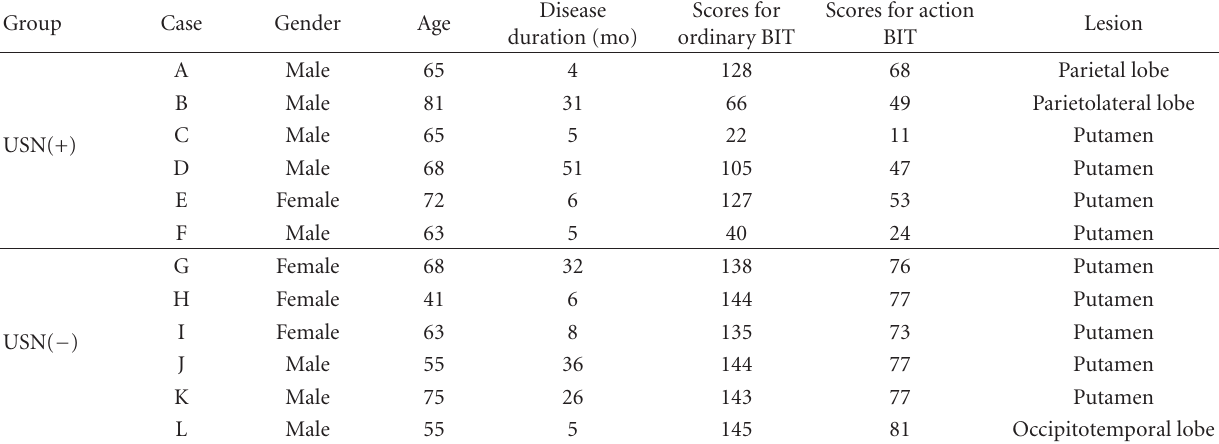
Table 1: Characteristic of